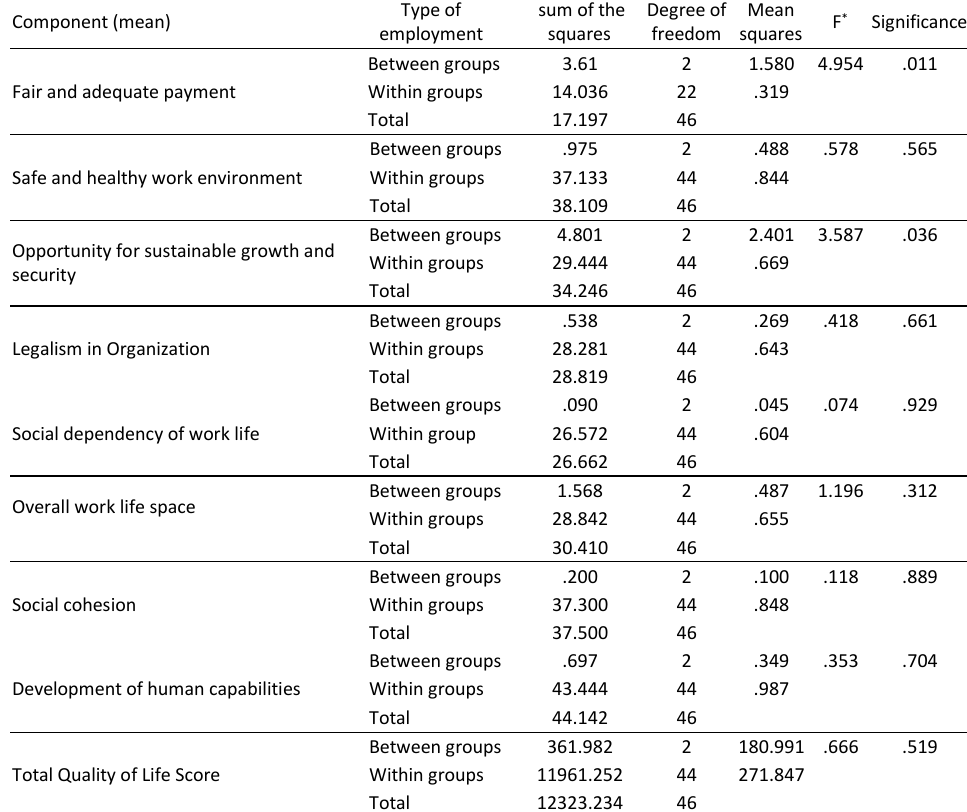
Table 3: Inferential statistics of comparisons of means using F test based on type of employment Component (mean)